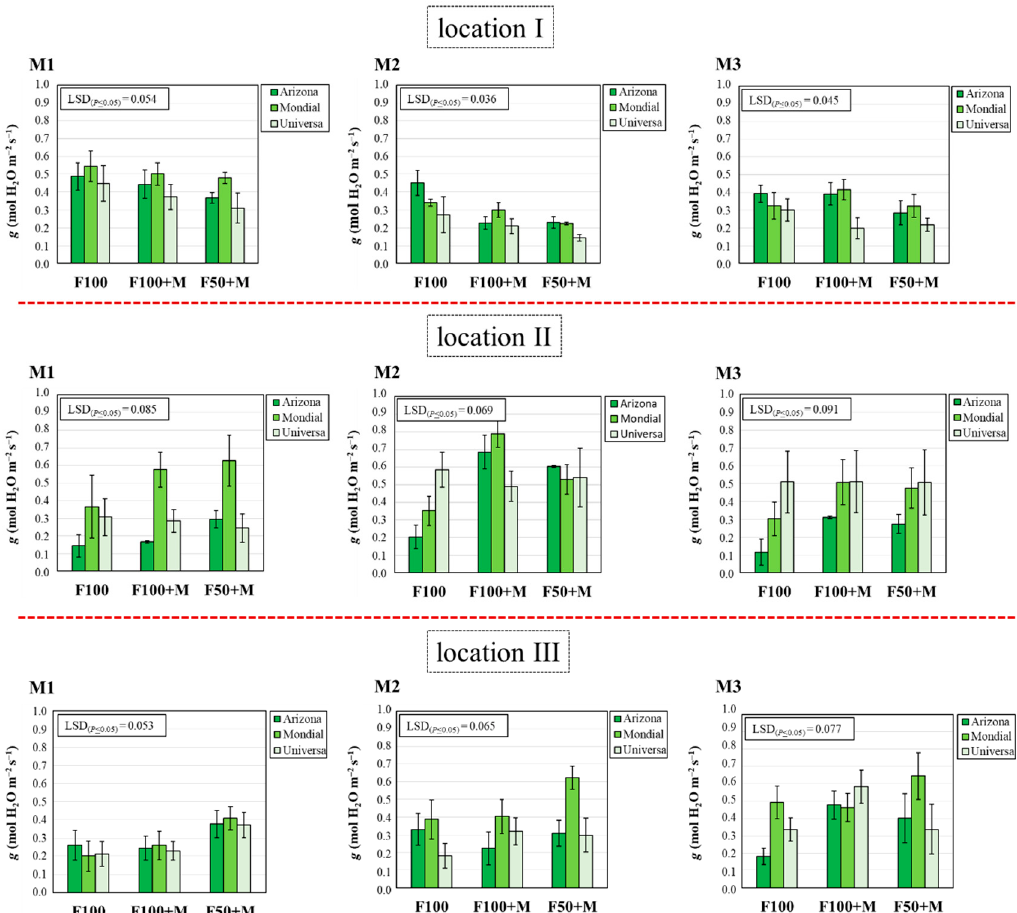
Figure 7. Stomatal conductance (mol H 2 O m − 2 s − 1 ) of leaves of early crop potato organically grown in highly calcareous soils as affected by fertilization management, soil type and potato cultivar. The Least Significant Difference (LSD) interaction was calculated with the Fisher’s protected LSD test at α = 0.05. Each bar indicates means ± standard deviation ( n = 5). F100: optimal fertilization without mycorrhizal inoculation (control); F100+M: optimal fertilization with mycorrhizal inoculation; F50+M: sub-optimal fertilization with mycorrhizal inoculation; ‘Arizona’, ‘Mondial’ and ‘Universa’: potato cultivars. M1, M2 and M3: first, second and third measurement date.